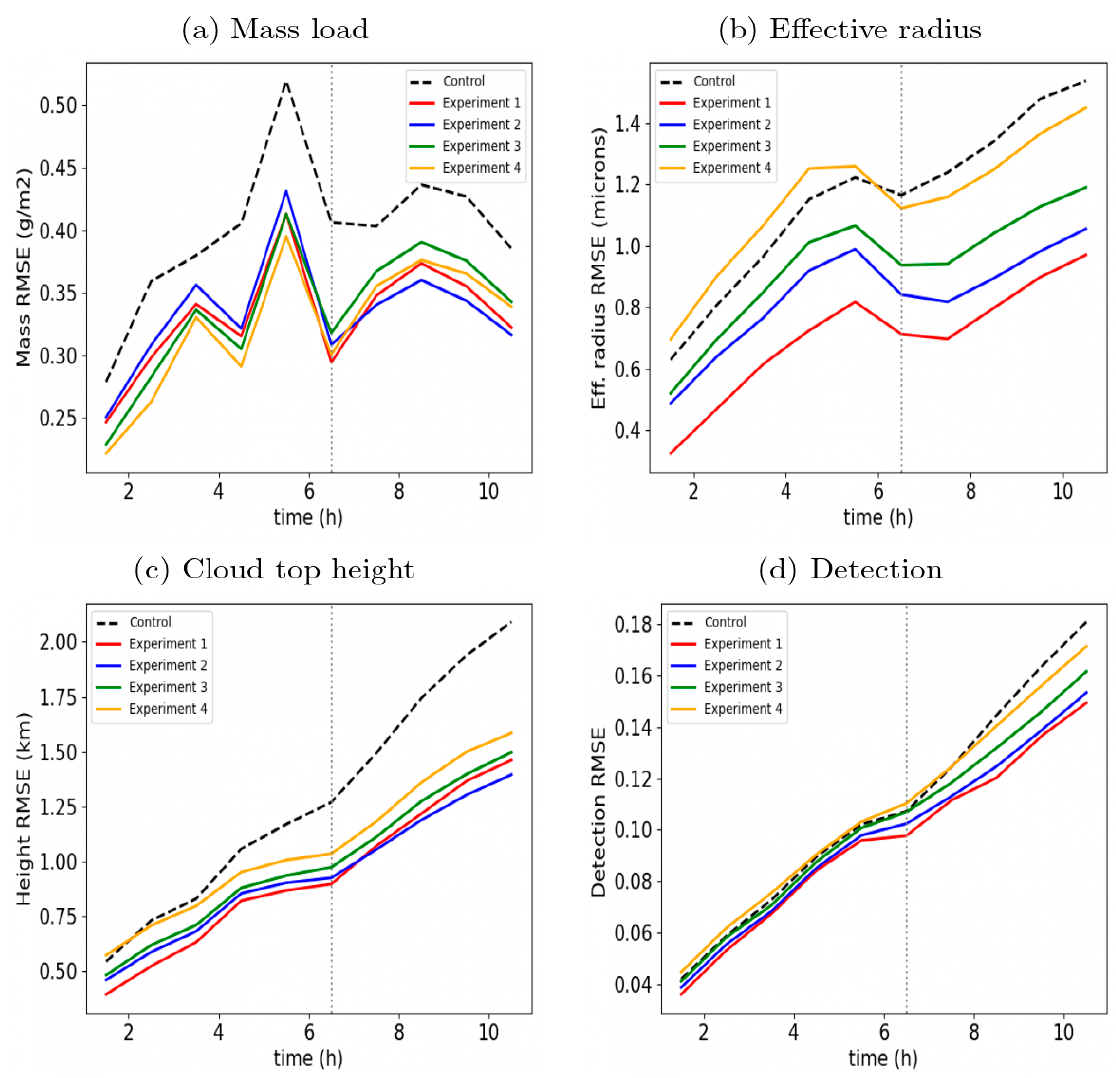
Figure 8. Ensemble mean root mean square error (RMSE) scores for different fields as a function of time for the control and different experiments in this study. The experiments utilize different values of 𝛽 (see Table 2). Lower RMSE values indicate better ensemble mean skill. The dotted vertical line demarcates the analysis and forecast periods.